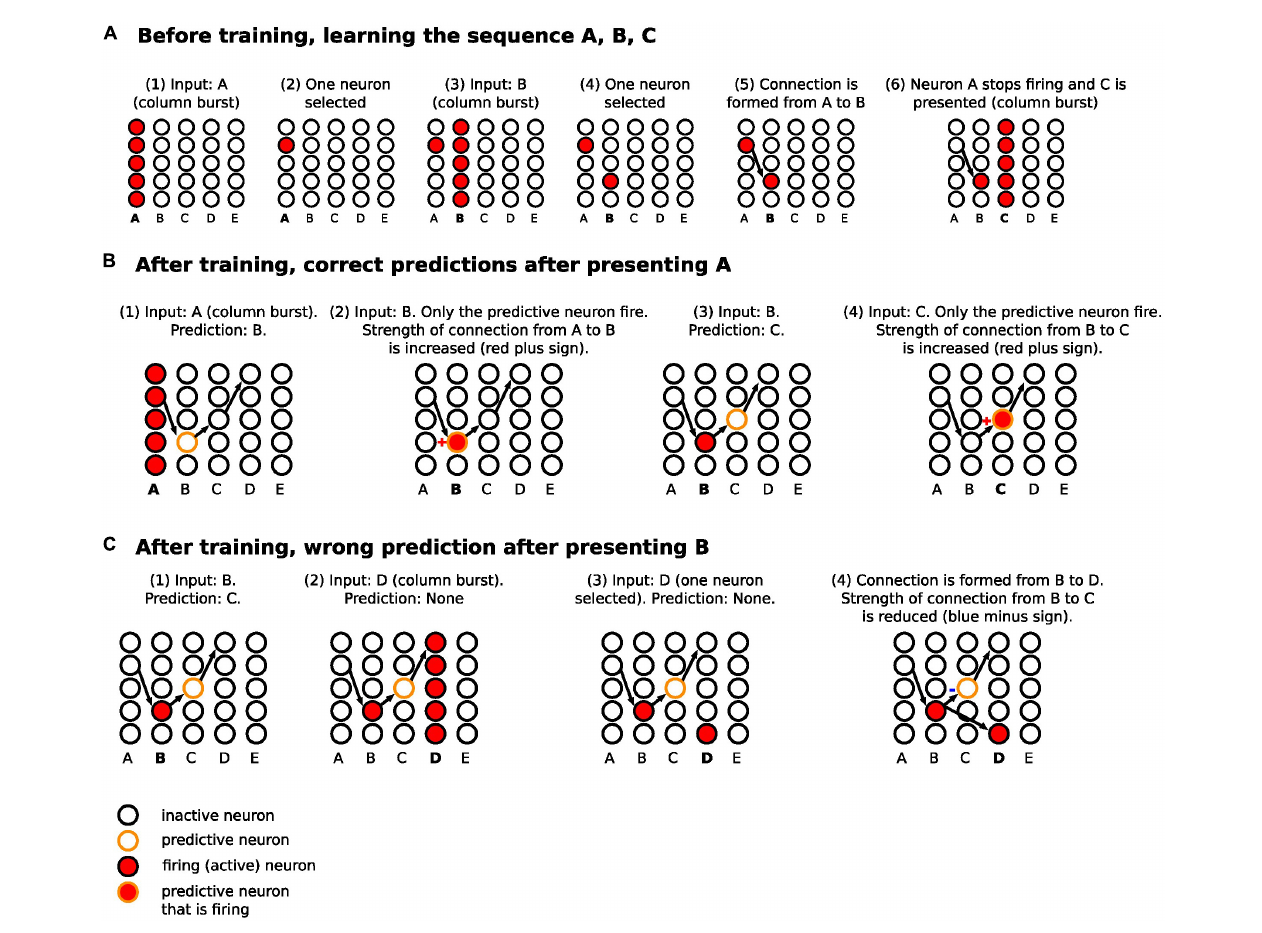
FIGURE2 Schematic diagram for the steps of learning and predicting in HTM. (A) The sequence A, B, C is presented to the temporal memory algorithm. Each minicolumn represents the receptive field of an input. Since the network has not learned any sequences, the presentation of each of the letters fires all the neurons in a minicolumn (minicolumn burst). (B) After learning, the presentation of A predicts B. Presenting B confirms the prediction, strengthening the connection from A to B (same for predicting C after presenting B). (C) After B is presented, C is predicted. However, D is presented after that, firing all the neurons in minicolumn corresponding to D. This results in making a new connection from a neuron in the B minicolumn to a neuron in the D minicolumn, with reduction of connection strength from B to C. Of note, we are separating the before training and after training phase to simplify the description, but learning and predicting happens